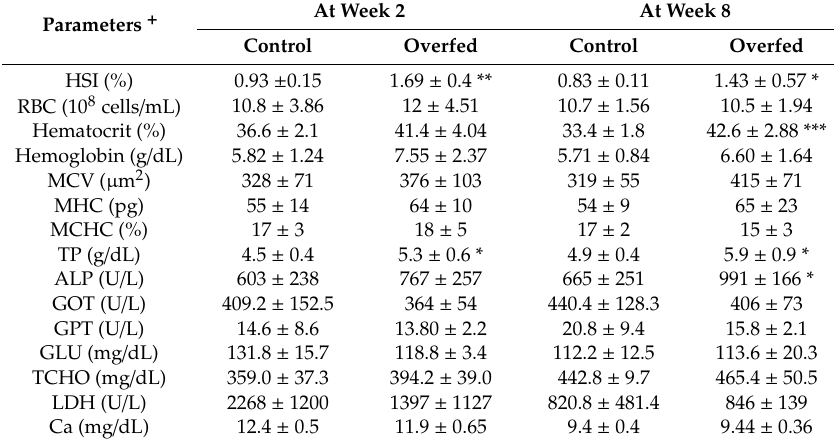
Table 1. Hepatosomatic index (HSI) and serological/ hematological changes (mean ± S.D.) in rainbow trout overfed for 2 and 8 weeks.